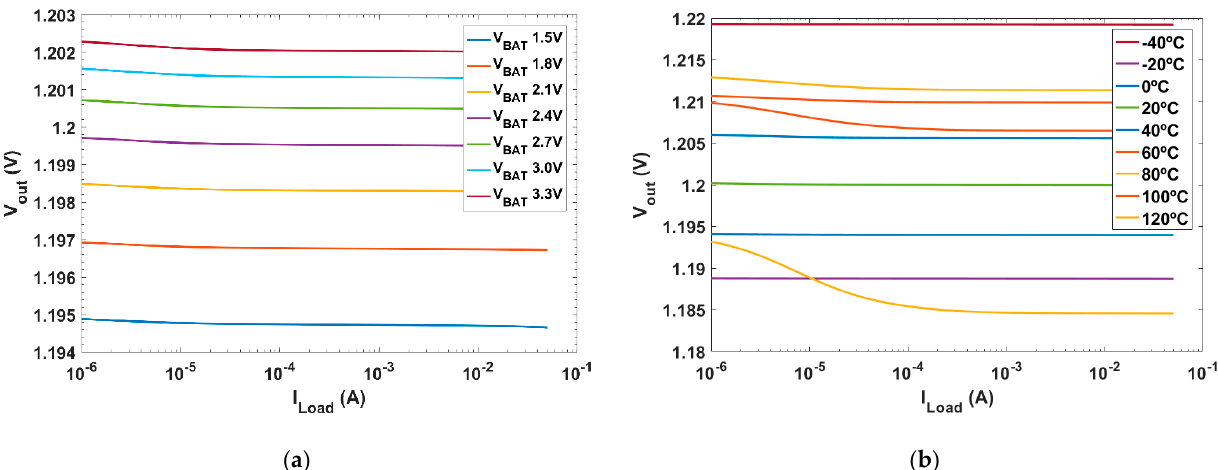
Figure 13. Line regulation for different: ( a ) load currents; and ( b ) temperatures (under maximum load current condition).